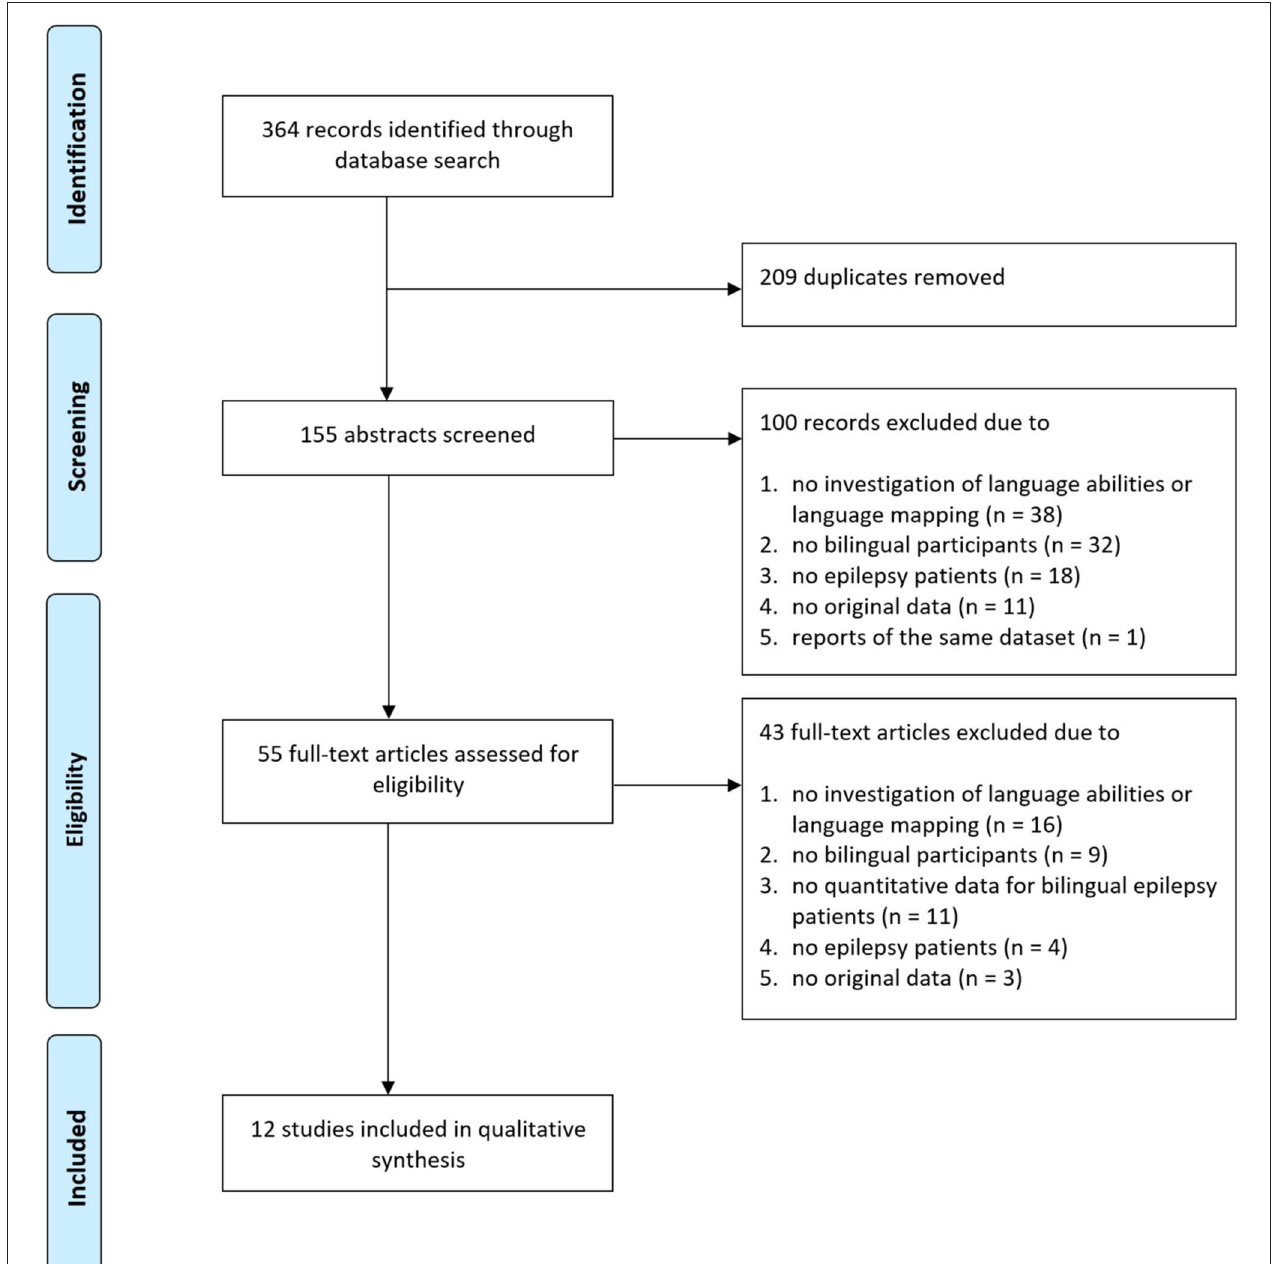
FIGURE 1 | Flow diagram depicting search process and study selection.